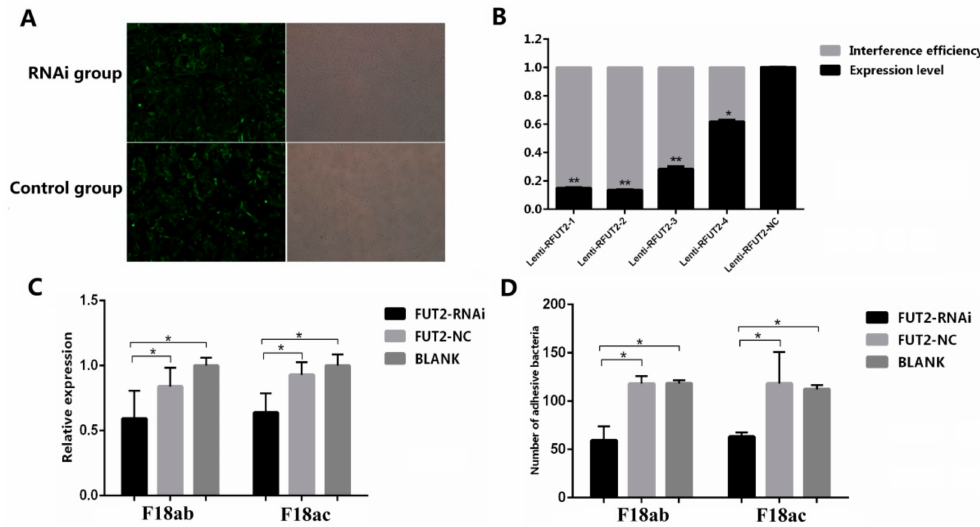
Figure 5. The effect of the FUT2 gene knockdown on the adhesion of E. coli F18 to IPEC-J2 cells. ( A ) Green fluorescence protein (GFP) expression recorded under a fluorescence microscope (100 × ); ( B ) Interference efficiency evaluation by detecting mRNA expression levels of FUT2 in non-treated (BLANK) cells and those transfected with lentiviruses containing non-silencing small hairpin RNA ( FUT2 -NC) and FUT2 -RNAi determined by qRT-PCR analysis, data are shown as mean ± SD, n = 3 biological replicates, ** p < 0.01, * p < 0.05; ( C , D ) Adhesion of the F18 fimbria to IPEC-J2 cells analyzed by relative quantification ( C ) and bacteria enumeration ( D ) detection, data are shown as mean ± SD, n = 3 biological replicates, * p < 0.05.